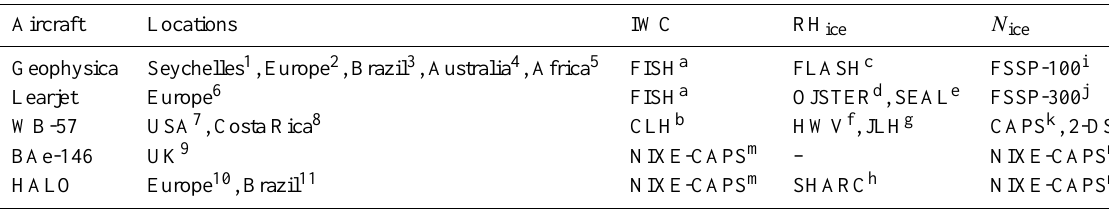
Figure 1. Aircraft flight paths during the campaigns listed above. Total number of flights: 104, total time of IWC measurements: 93.6h. Table 1. Overview of campaigns and instruments. IWC: ice water content, RH ice : relative humidity over ice, N ice : ice crystal number